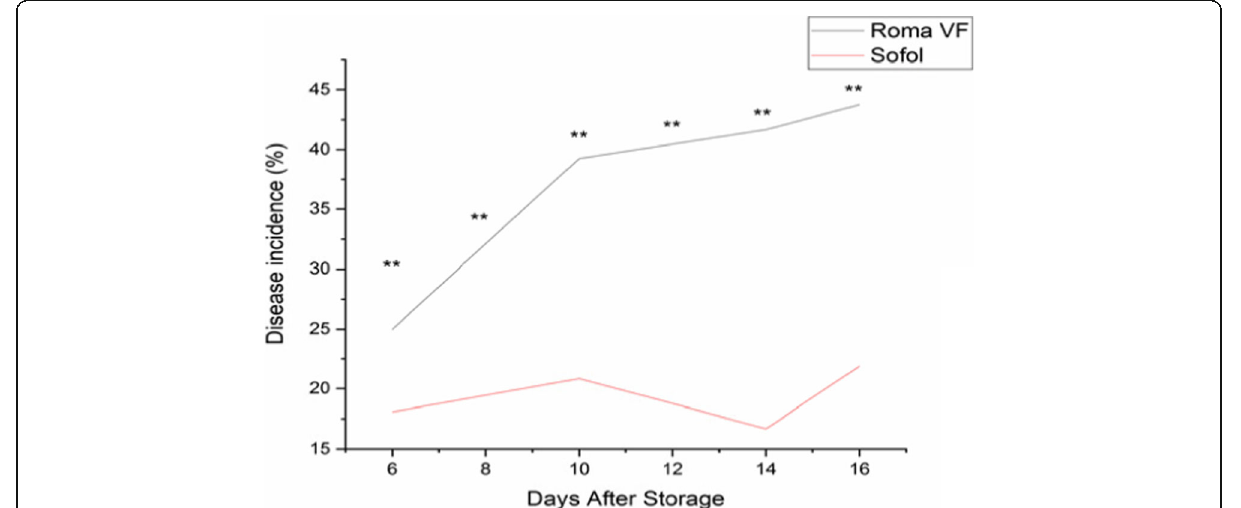
Fig. 3 Effect of variety on disease incidence of tomato during storage and